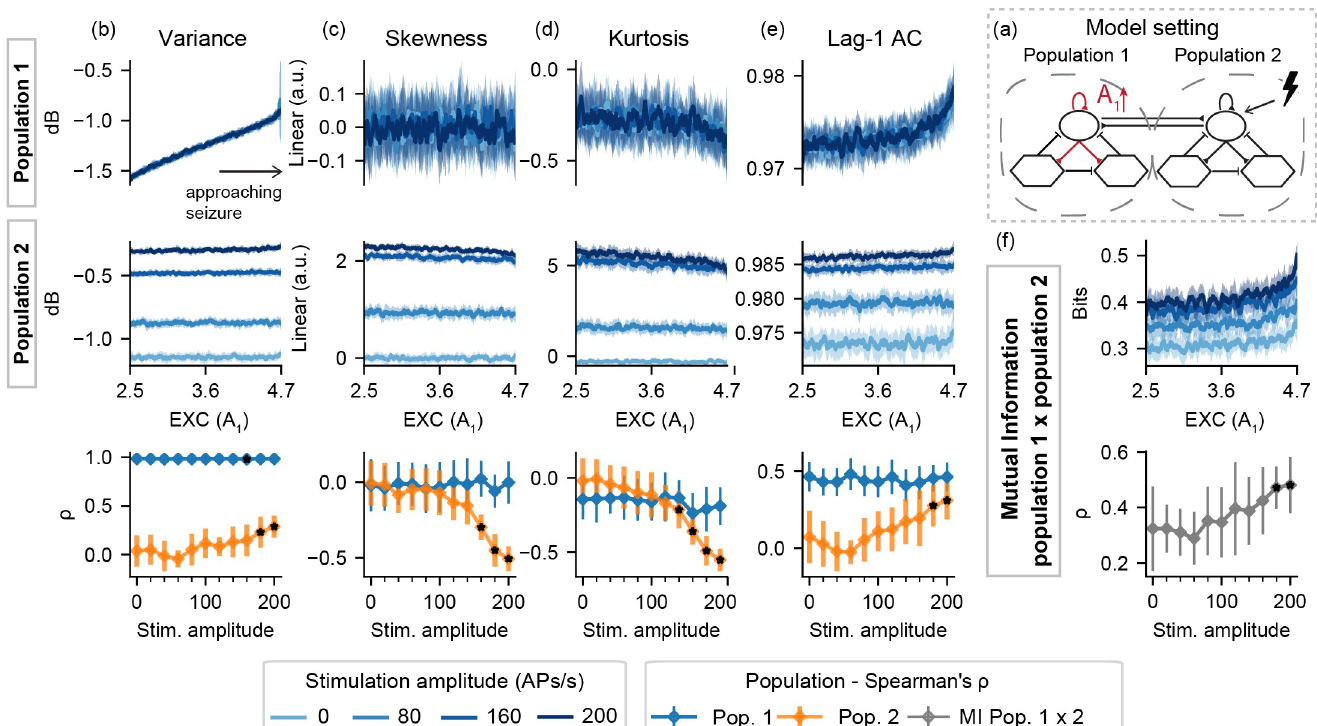
Fig 3. Feature series and probing efficiency for model setting I-A. For population 1, excitability increase is correlated with variance even with passive observation. However, increased amplitude probing responses from population 2 reflect gradual changes of A 1 towards ictogenesis. (a) shows a simplified illustration of the model setting. For (b) variance, (c) skewness, (d) kurtosis and (e) lag-1 AC features, top rows show feature values extracted from the output of each population, as the excitability gain parameter (A 1 ) is increased. (f) shows the inter-population synchronization as measured by the mutual information feature. Bottom row shows Spearman’s rank correlation between each feature series and the shifted parameter (A 1 ), as stimulus amplitude is increased. Black dots indicate significant differences from passive observation (stim. Amplitude = 0) according to Tukey’s